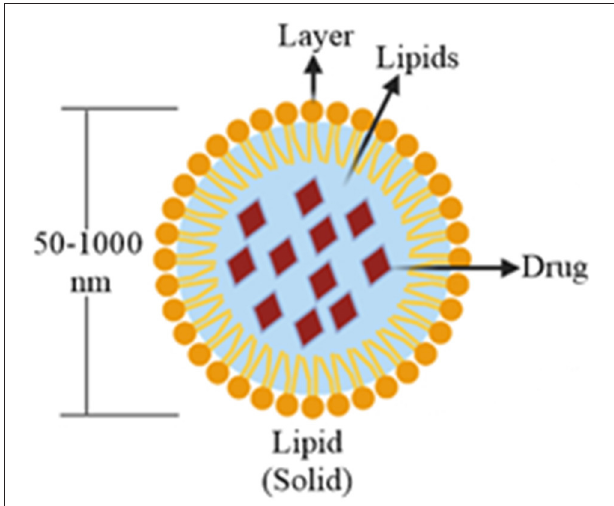
FIGURE 3 | Structure of drug-loaded SLN particle.